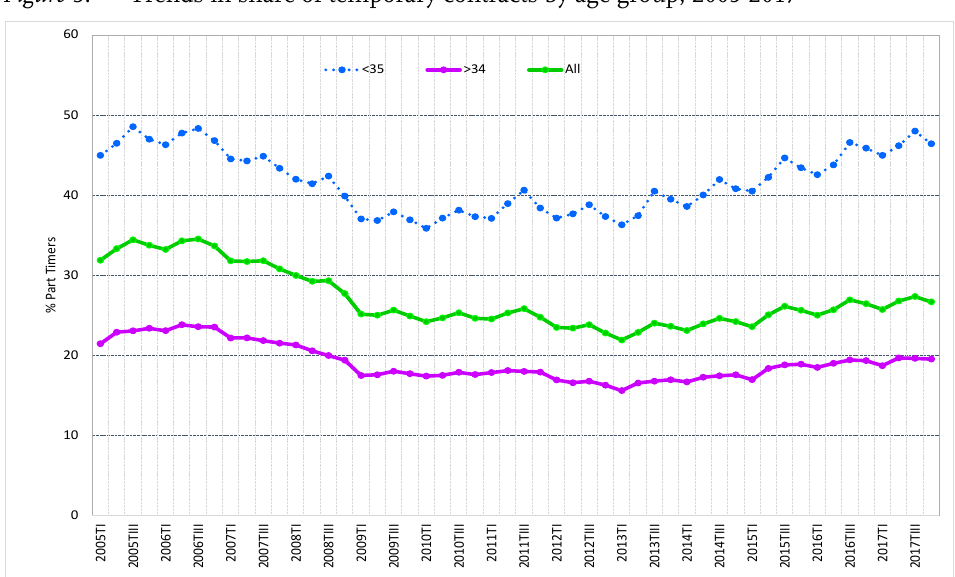
Figure 3 : Trends in share of temporary contracts by age group, 2005-2017